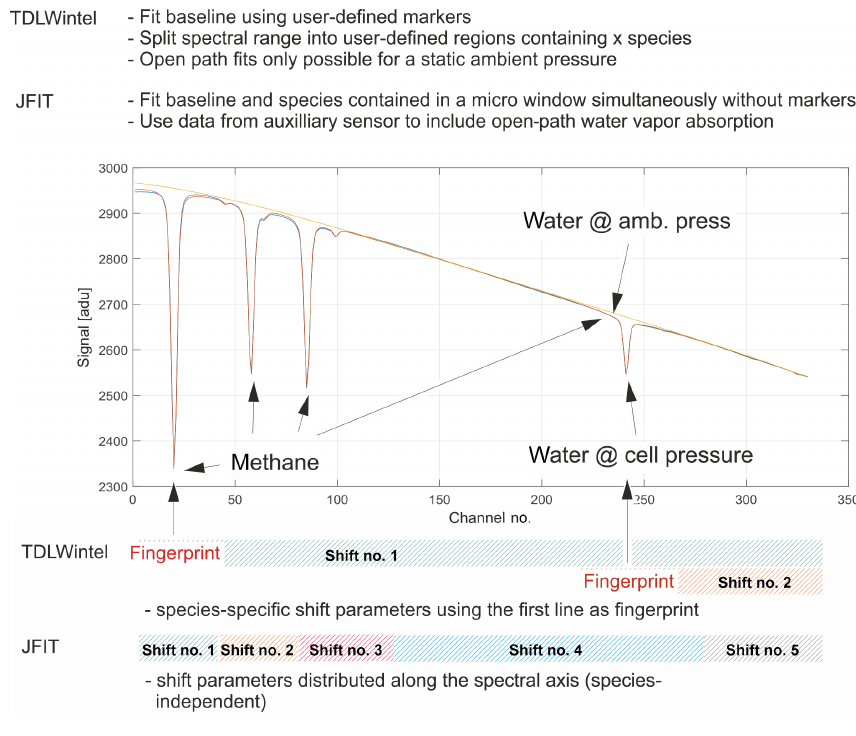
Figure 4. Schematic depicting the handling of spectral shift parameters and baseline modeling. The spectral baseline is fitted as a polynomial together with absorption features over the entire fit window. Shift parameters have been implemented in a species-independent way. Open- path water is also included in the